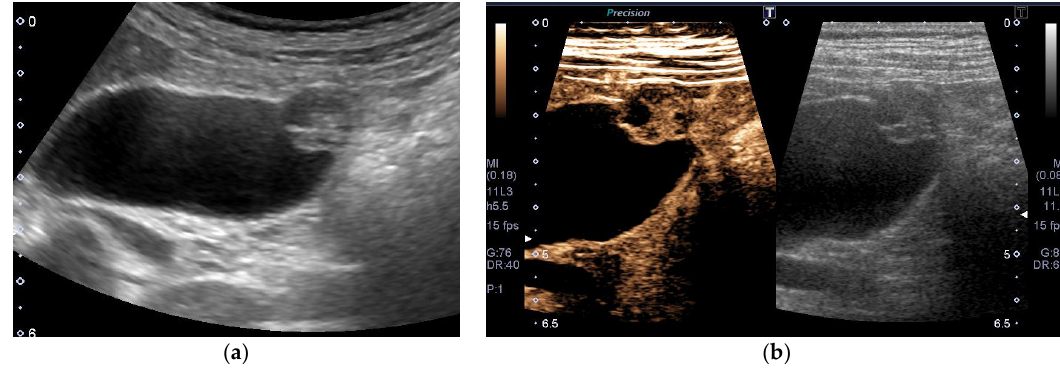
Figure 7. Cystic structures (anechoic spots) corresponding to RAS. Compared to the conventional US ( a ), CEUS clearly depicted cystic structures inside the fundal ADM ( b ).